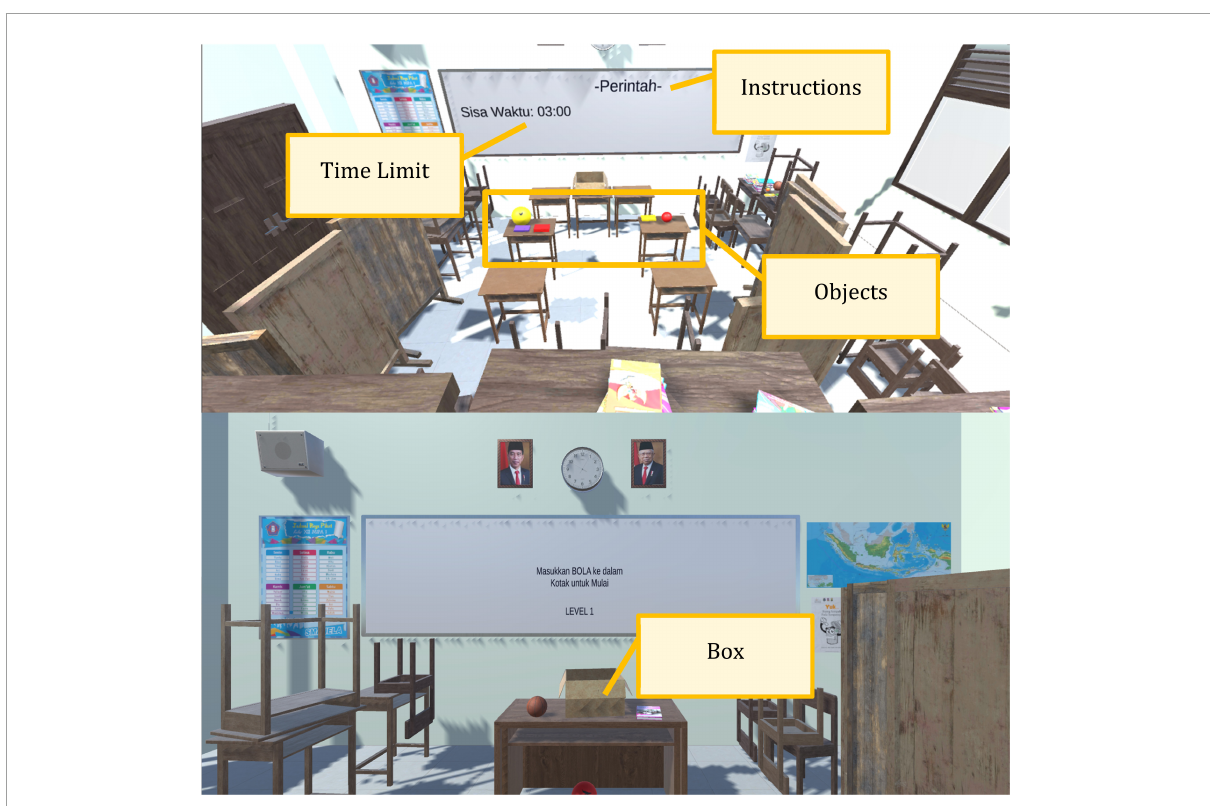
FIGURE2 The attention deficits/hyperactivity disorder-virtual reality (ADHD-VR) diagnostic tool prototype